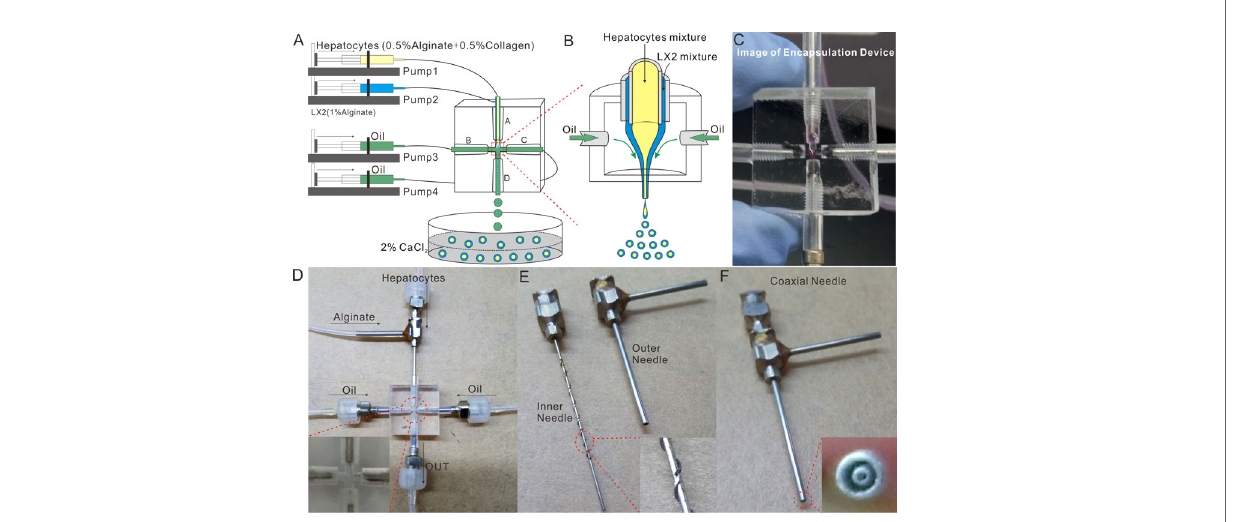
FIGURE 2 | Design and Fabrication of the Microspheres-generating Chip. (A) Schematic of the bilayer microspheres-generating system; (B) Schematic of focusing the inner and outer phases to be cone-shaped; (C) The physical picture of focusing the inner and outer phases to be cone-shaped; (D) The physical picture of the microspheres-generating chip; (E) The exploded view of the coaxial needle; (F) Image of the assembled coaxial